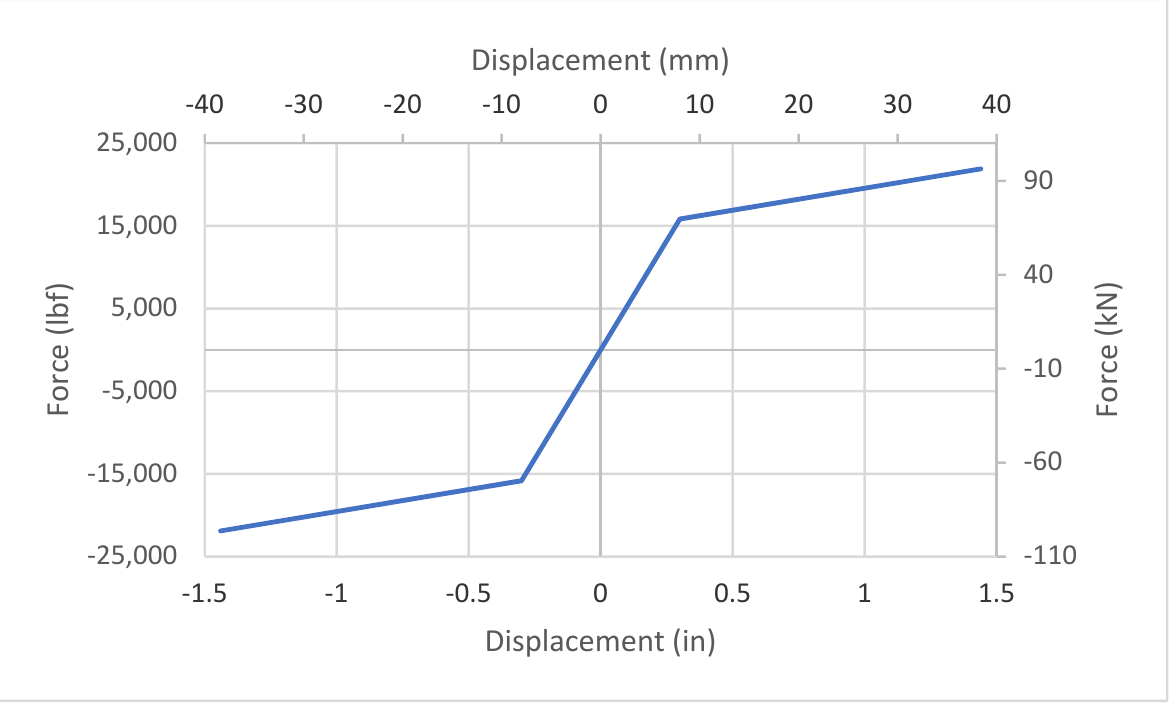
Figure 17. Bilinear load-displacement response for vertical movement in UFP connector—scaled for a 60% building size.